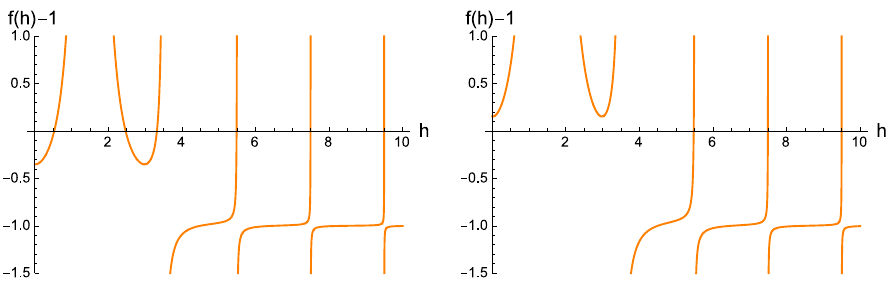
Figure 16 . Plots of f ( h ) (cid:0) 1 for d = 3 at g = 0 : 15 (left) and g = 0 : 19 (right). The zeros on the left panel correspond (from left to right) to h 0 (cid:0) , h 0+ , and h 1 to h 4 . On the right panel h 2 to h 4 are the only remaining real roots. In this case g 0 ’ 0 : 186135 and g (cid:3) (cid:0) g 0 ’ 5 : 7 (cid:2) 10 (cid:0) 5